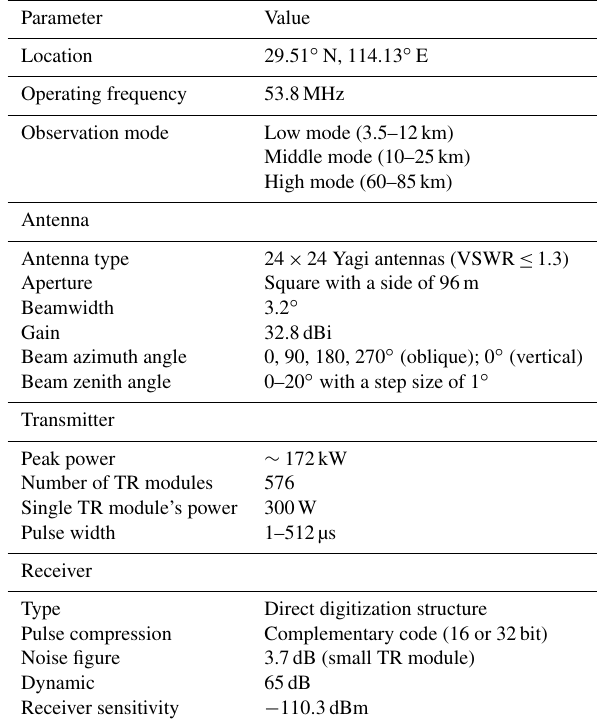
Table 1. Specifications of the Wuhan MST